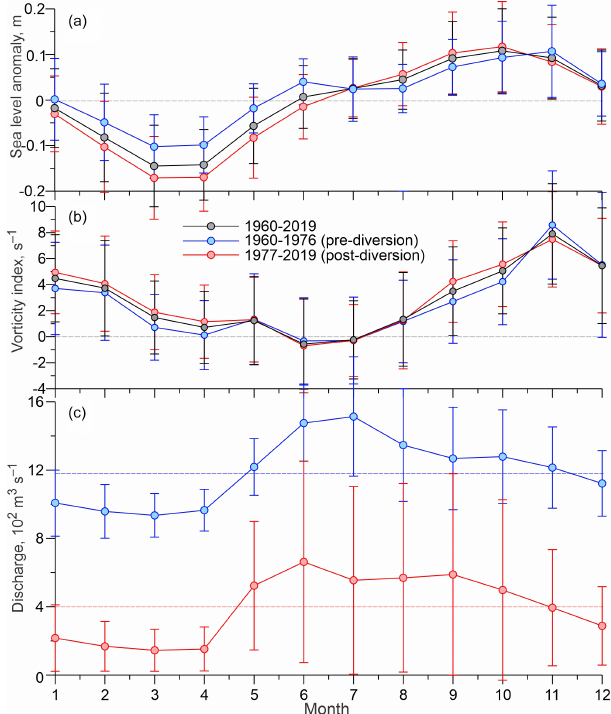
Figure 5. Seasonal cycle of (a) SLA at Churchill (m), (b) atmo- spheric vorticity over Hudson Bay (s − 1 ), and (c) Churchill River discharge (10 2 m 3 s − 1 ). Seasonal cycle derived using monthly- mean data for (a, b) 1950–2019 (black), (a, b) 1950–1976 (blue), and (c) 1960–1976 (blue) before the Churchill River diversion, and (a, b, c) 1977–2018 (red) after the Churchill River diversion. Error bars show ± 1 standard deviation of the mean. (c) Blue and pink dashed lines show the long-term mean discharge before and after diversion,